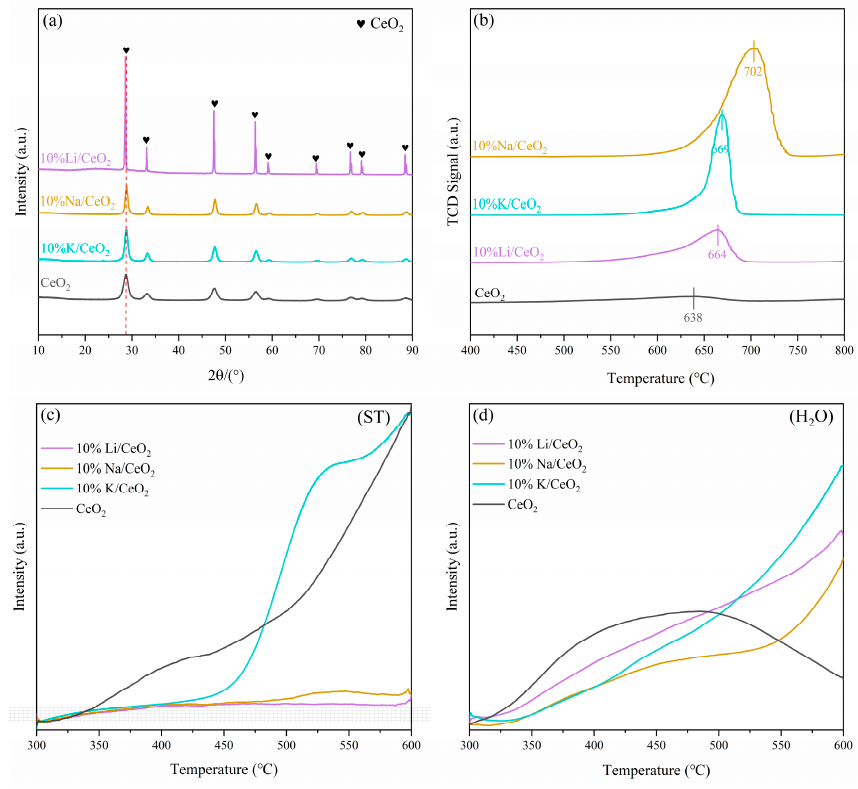
Figure 2. ( a ) XRD, ( b ) H 2 -TPR, ( c ) styrene (ST) and ( d ) H 2 O mass spectra of EB-TPR (reaction condi- tions: ramp rate 10 °C/min, T EB = 25 °C, space velocity = 7.5 h − 1 ) for 10%X/CeO 2 (X = Li, Na, K). Figure 2c showed the styrene generation in EB-TPR (EB-temperature program reduc- tion) experiment at 300–600 °C. As shown in the results, styrene started to be generated at 350 °C on the pure CeO 2 , and the generation amount of styrene was increased rapidly after the temperature reached 500 °C. For 10%K/CeO 2 , it started to generate styrene from 400 °C. Styrene ʹ s generation performance increased sharply after the temperature reached 450 °C, while the styrene generation rate slowed down after 550 °C. In contrast, there was almost no styrene generation on the Li/Na modi fi ed CeO 2 . This showed that the oxygen storage capacity was not a decisive factor to enhance the catalytic activity. Figure 2d shows that 10%K/CeO 2 exhibited a strong rising trend of the H 2 O mass spectrum after 450 °C. Combined with the rising trend of the CO 2 mass spectrum (Figure S1), this suggests that the la tt ice oxygen release rate of 10%K/CeO 2 was accelerated by the increase in reaction temperature, which led to the partial oxidation. Therefore, it was necessary to select a suitable reaction temperature to reduce the excessive oxidation of EB on the catalyst. These results reveal that the doping of the alkali metal Li/Na/K to the CeO 2 surface could greatly improve its oxygen storage capacity. From Figure 3a, the amount of styrene generation was gradually increased at 500 °C with the reaction proceeds. Figure 3b shows the product distribution of the oxidative de- hydrogenation of ethylbenzene. The generation amounts of by-products on 10%Li/CeO 2 were the highest, with only 54.5% styrene selectivity and 17.3% ethylbenzene conversion. The styrene selectivity of 10%Na/CeO 2 could reach 86.9%, while ethylbenzene conversion was only 29.0%. The best catalytic performance was from 10%K/CeO 2 with 92.4% styrene selectivity and 71.9% ethylbenzene conversion. The catalytic performance of ethylbenzene oxidative dehydrogenation was related to the type of alkali metal. CeO 2 , with the doping of Li and Na, su ff ered from a serious decrease in catalytic performance and an increase in excessive oxidation. Therefore, alkali metal K was chosen for the surface modi fi cation of CeO 2 to further improve the catalytic performance.